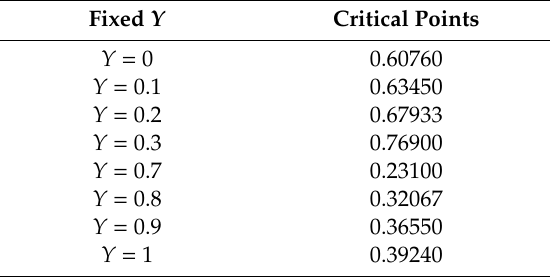
Table 1. Critical points for several fixed Y